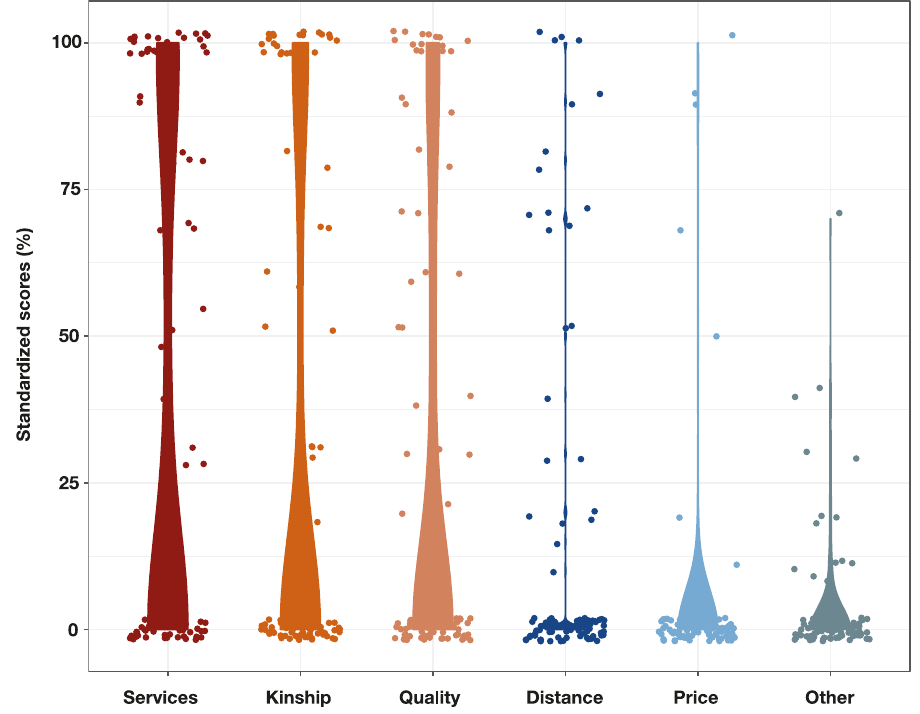
Figure 4. Standardised scores for the reasons stated by farmers for their choice of veterinary drug shops.